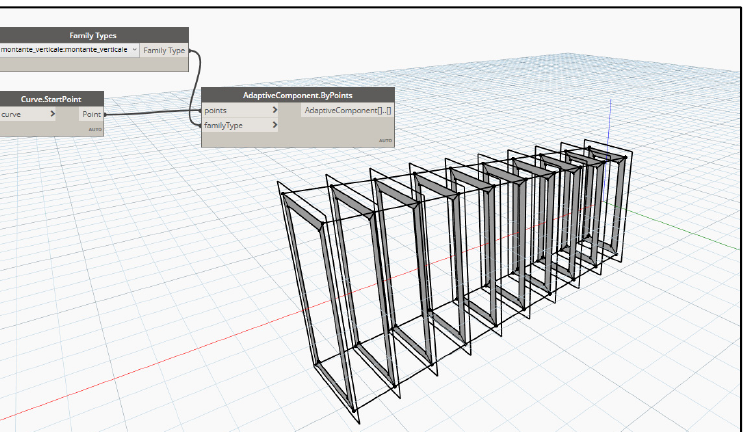
Figure 7. Adaptive.Component.ByPoint node for the insertion of adaptive families within the generated surfaces. As the conclusion of this phase, a 3D model of the Decay Volume is obtained in Revit, and its view is presented in Figure 8.